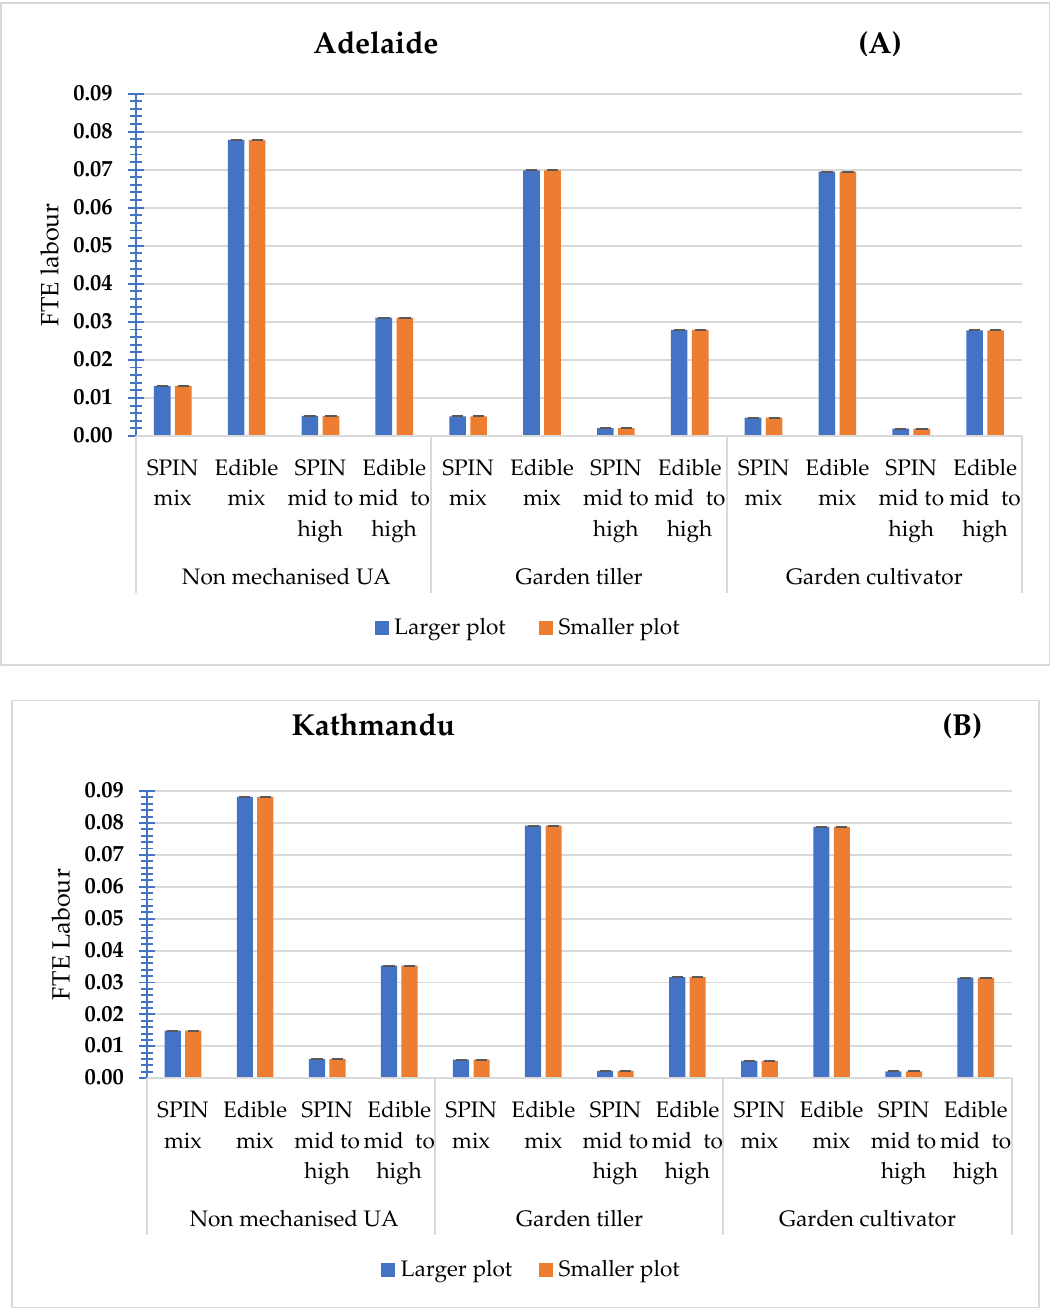
Figure 4. ( A , B ): Full-time labour equivalent calculation in Adelaide and Kathmandu Valley. The I marker represents the standard error of the mean.